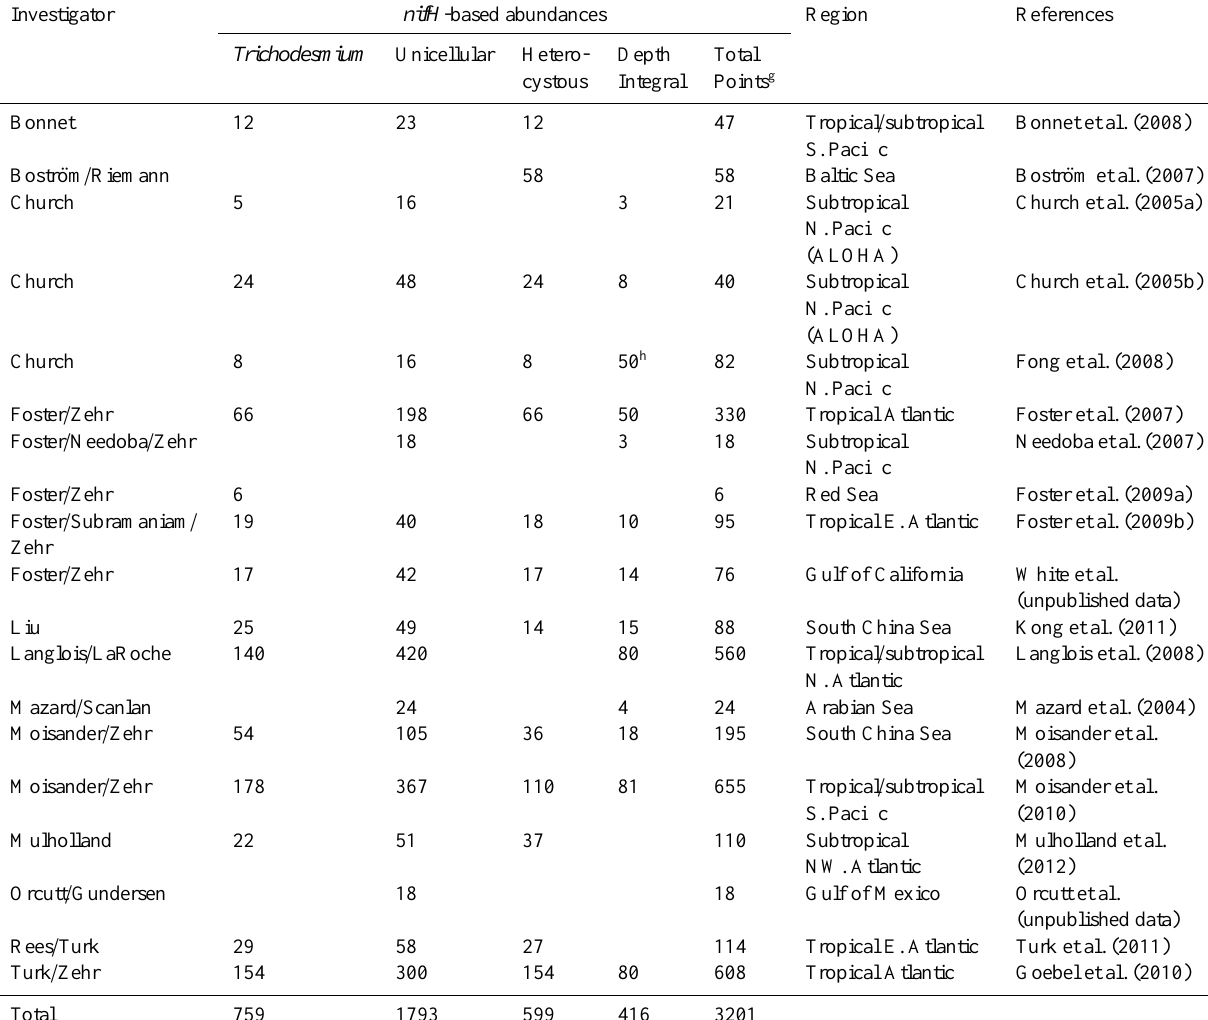
Table 1c. Summary of data points for nifH -based abundances from qPCR assays, including volumetric measurements of Trichodesmium , unicellular cyanobacteria and heterocystous cyanobacteria and their